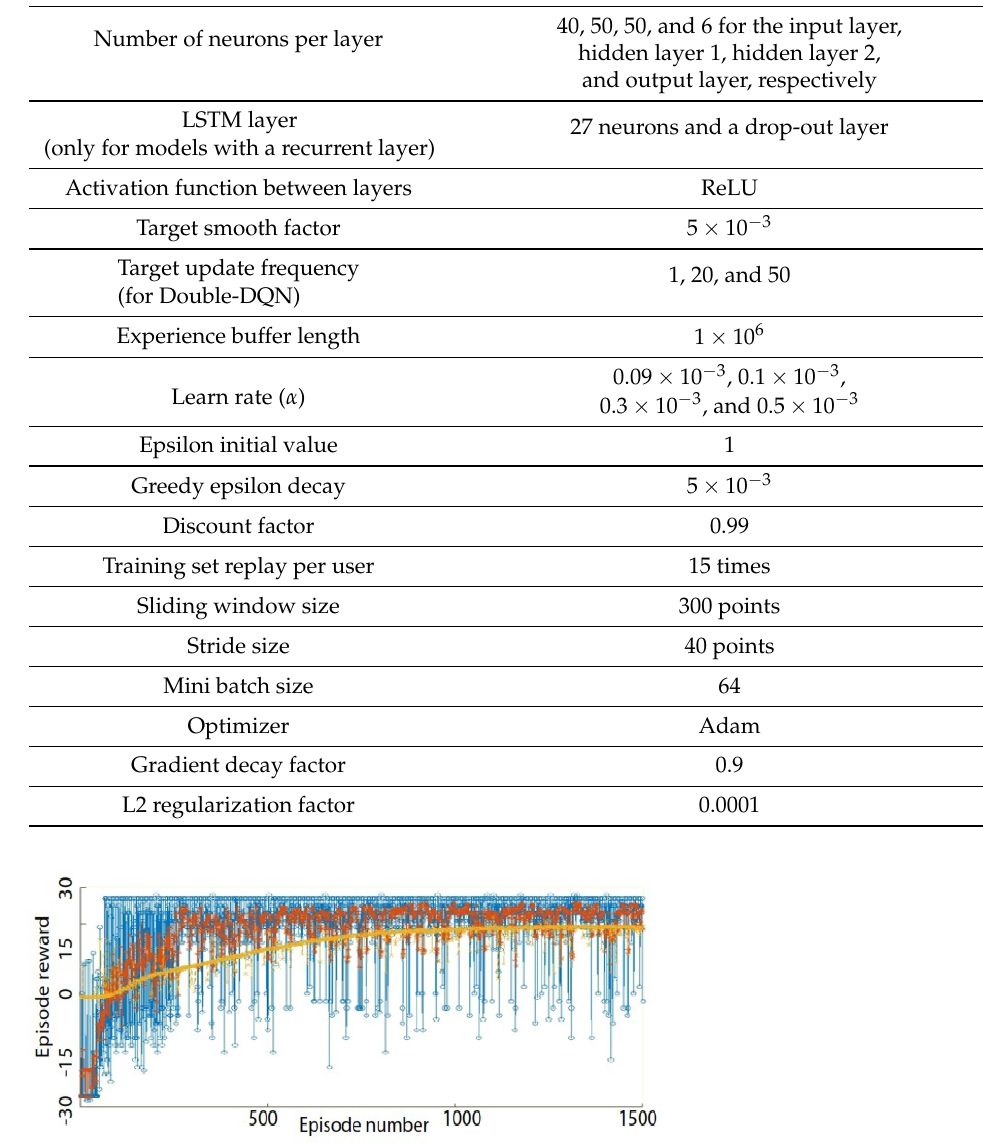
Figure 6. Episode rewards versus episode number. User-specific HGR training sample results for User 1 with DQN. We can observe the convergence of the estimate of the discounted long-term reward at the start of each episode (yellow line) to the current episode reward (blue line) and average reward of the last five steps (red